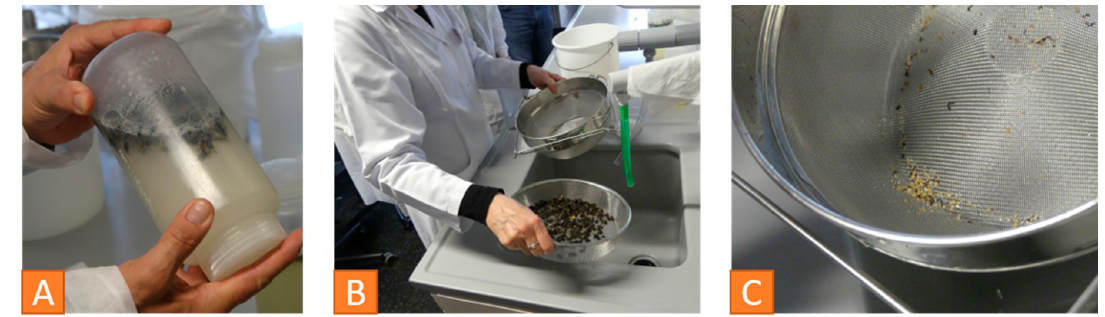
Figure 9. Varroa infestation control with the alcohol washing method, ( A ) shaking the honeybee sample in the ethanol solution, ( B ) straining the liquid in a sieve system, ( C ) mites in the smaller sieve can be counted. © Heike Aupperle-Lellbach.